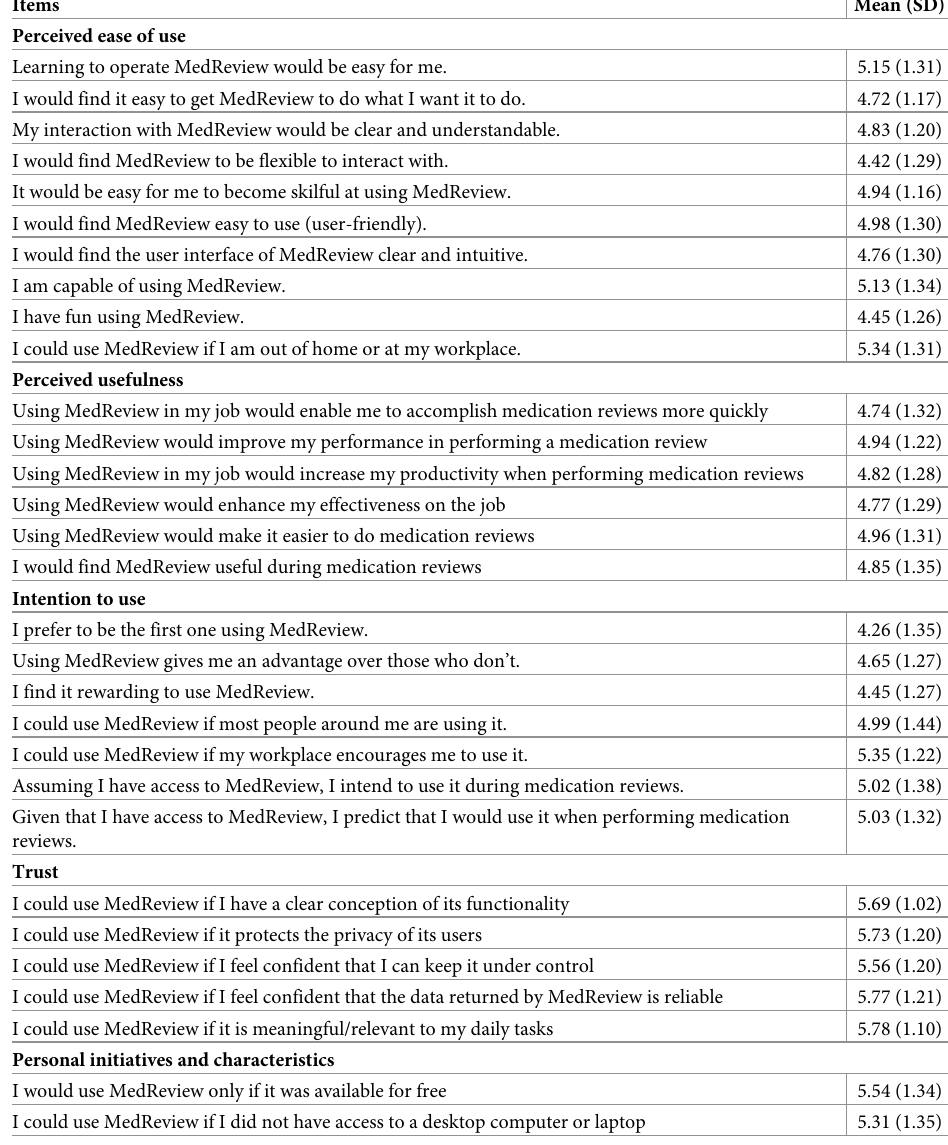
Table 3. Descriptive statistics of items in each domain in the survey for